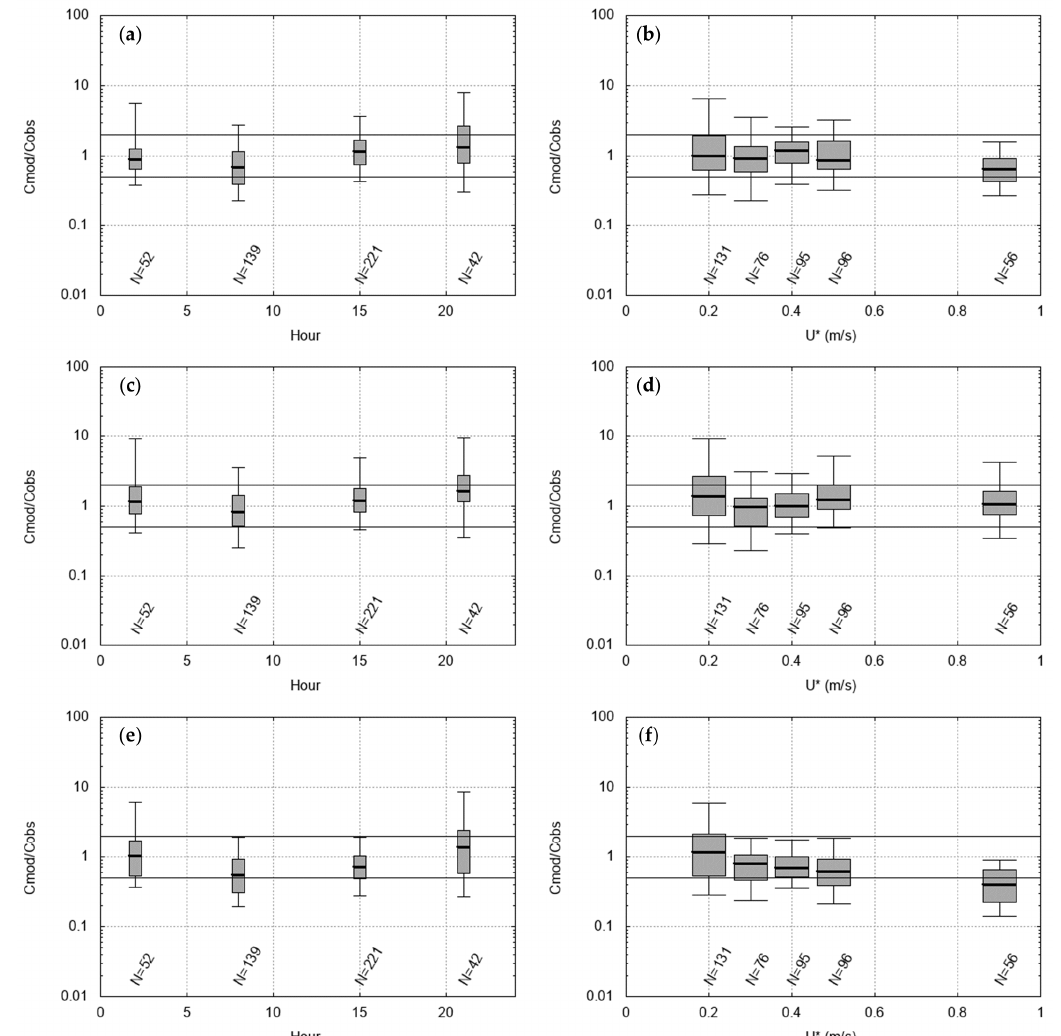
Figure 2. Residual box plots with respect to period of the day and friction velocity for Indianapolis best-quality data: ( a ) WT plume rise, period of the day; ( b ) WT plume rise, friction velocity; ( c ) JJ + RS plume rise, period of the day; ( d ) JJ + RS plume rise, friction velocity; ( e ) JJ + JJ plume rise, period of the day; ( f ) JJ + JJ plume rise, friction velocity.